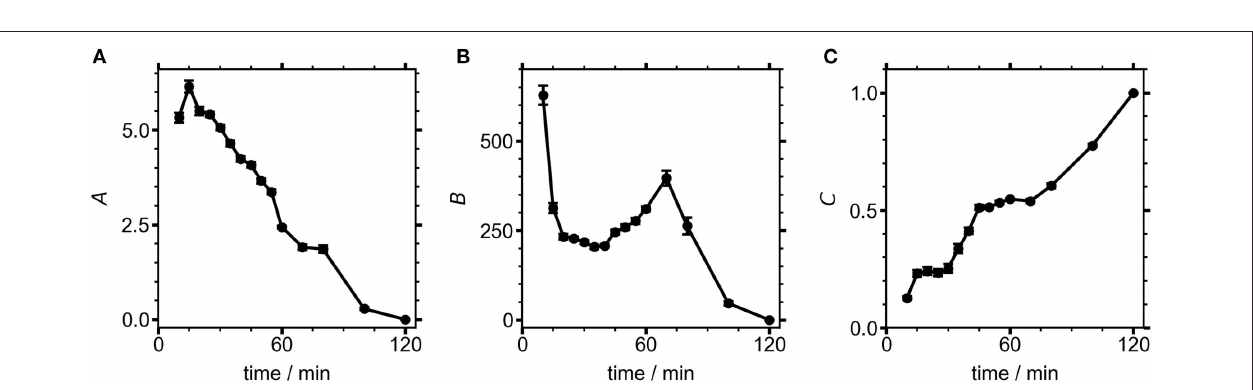
FIGURE 7 | Fit coefficients from Equation (2) for NCs measured at different growth times. Contributions from the (A) first and (B) second derivatives, as well as the (C) 120 min NC component to the overall fit.